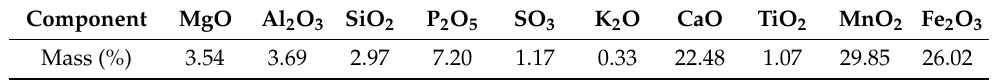
Table 2. Mineralogical analysis of the manganese ore.